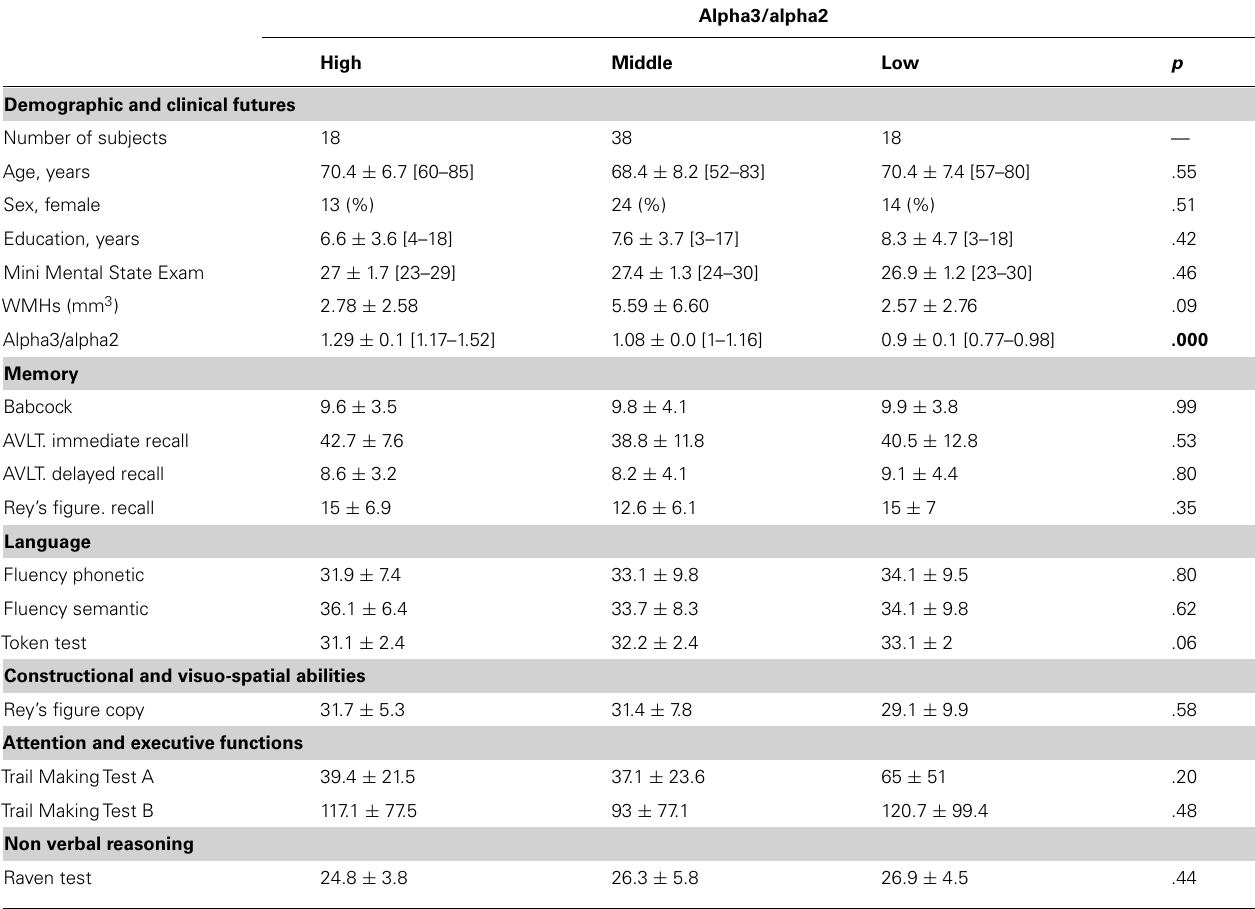
Table 1 | Demographic and cognitive characteristics in the whole sample, disaggregated for increased levels of alpha3/alpha2 Numbers denote mean ± standard deviation, number and [range].